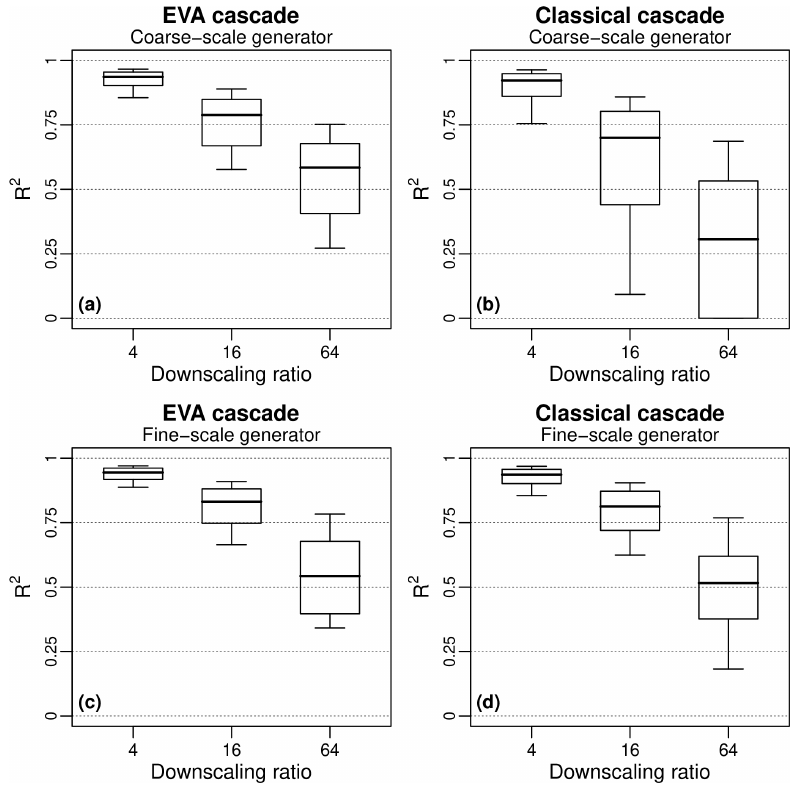
Figure 16. 10%, 25%, 50%, 75%, and 90% quantiles of the coefficient of determination R 2 between observed and downscaled rainfall fields for the 100 selected rain events. The values corresponding to the coarse-scale generator are given in Table 3. Table 3. 10%, 25%, 50%, 75%, and 90% quantiles of the coefficient of determination R 2 between observed and downscaled rain rates for the EVA and classical method and three different downscaling factors (coarse-scale sample generator only). 2km × 2km 4km × 4km 8km × 8km EVA Classical EVA Classical EVA Classical 10% 0.86 0.76 0.58 0.09 0.27 0.00 25% 0.90 0.86 0.67